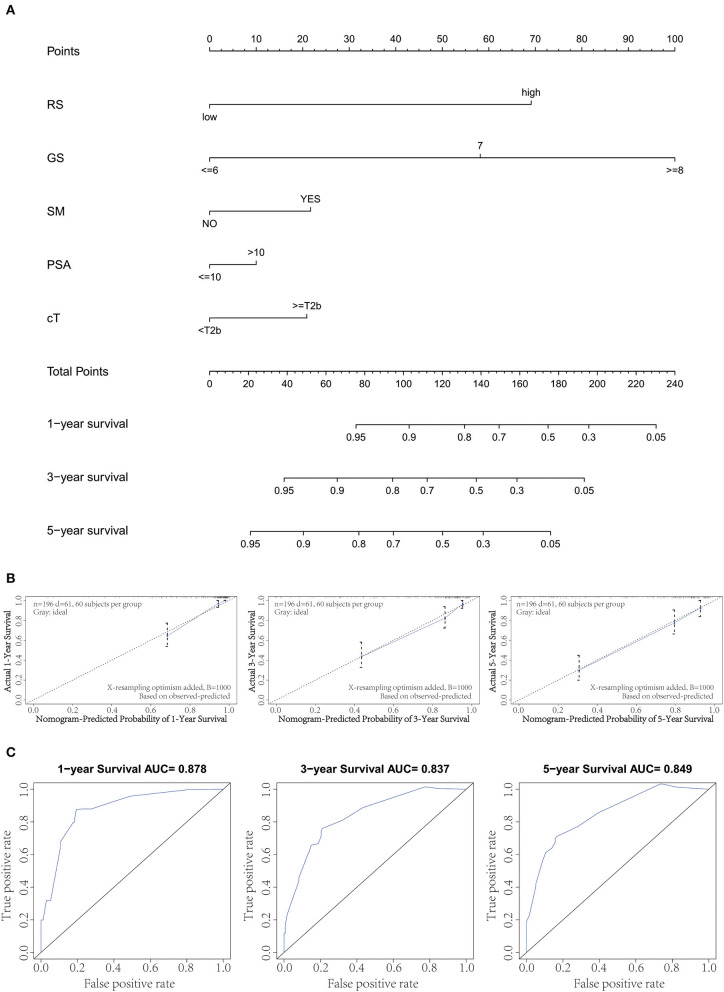
Combination of clinical variables to build a predictive nomogram. (A) Nomogram plot to predict 1-, 3-, and 5-year survival. (B) Calibration plot of the nomogram to predict 1-, 3-, and 5-year survival. (C) Receiver operating curve (ROC) curves of the nomogram to predict 1-, 3-, and 5-year survival.